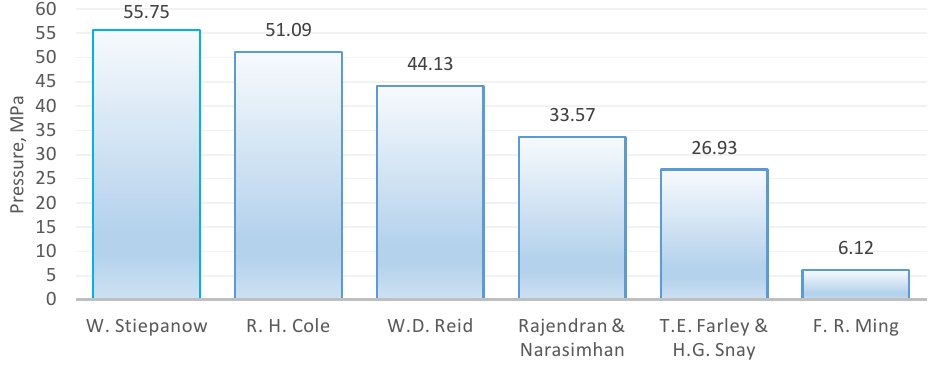
Figure 5. I + value calculated for the selected pressure waves in the 0–2 ms time range.